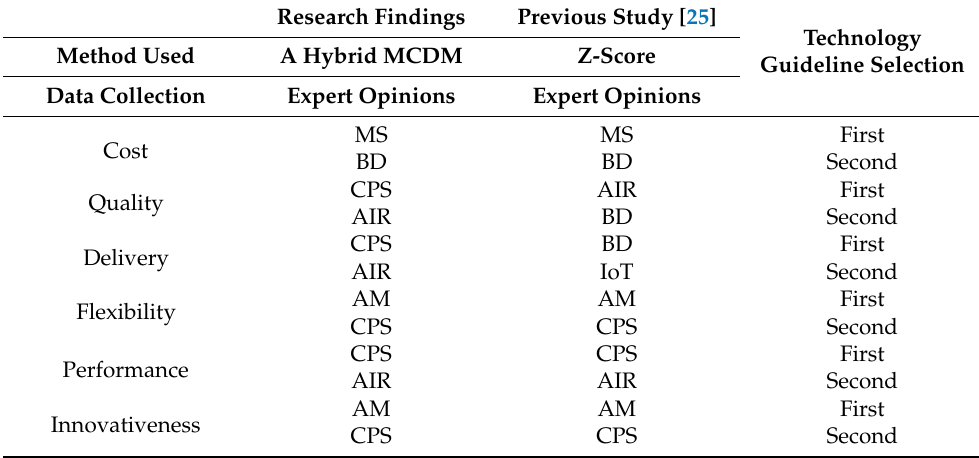
Table 13. Comparisons between previous results and current fi ndings considering I4.0 technologies selections